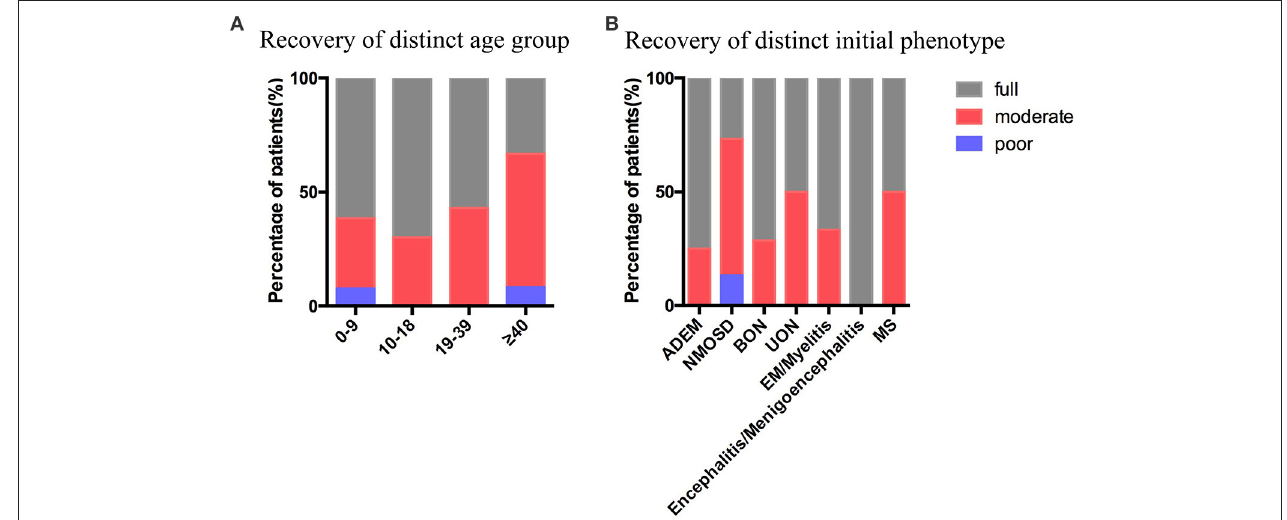
FIGURE 6 | Recovery at the last follow-up. (A) Recovery at the last follow-up stratified by the age groups. (B) Recovery at the last follow-up stratified by the initial phenotype. ADEM, acute disseminated encephalomyelitis; NMOSD, neuromyelitis optica spectrum disease; BON, bilateral optic neuritis; UON, unilateral optic neuritis; EM, encephalomyelitis; MS, multiple sclerosis. Full recovery was defined as EDSS = 0, moderate recovery was defined as 0 < EDSS ≤ 2, poor recovery was defined as EDSS ≥